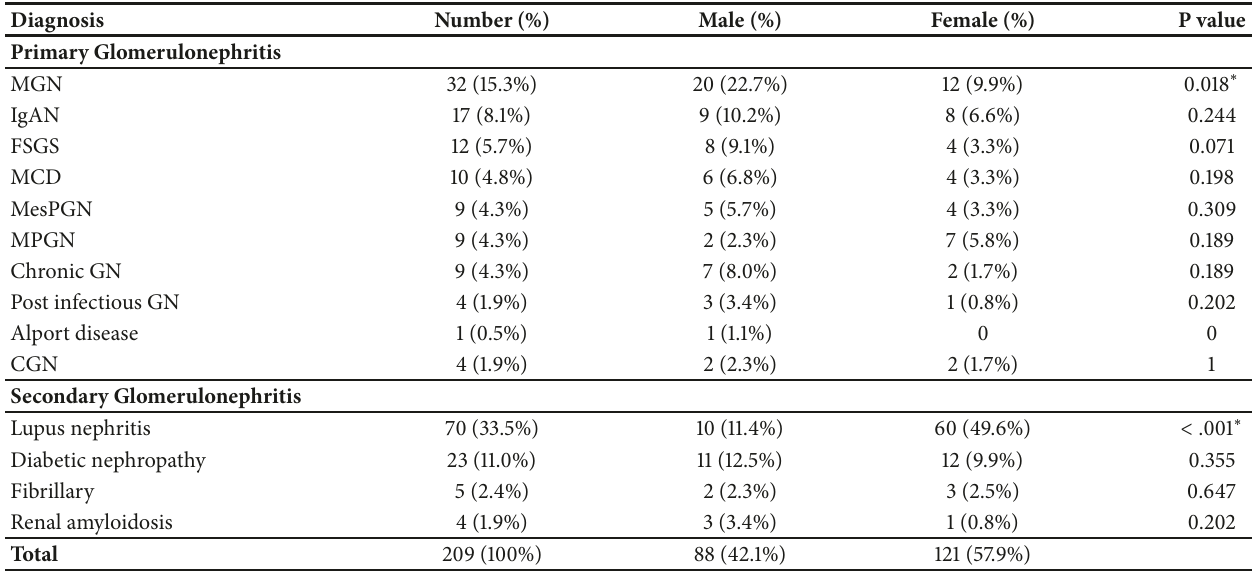
Table 1: Distribution of glomerular diseases based on incidence and patients’